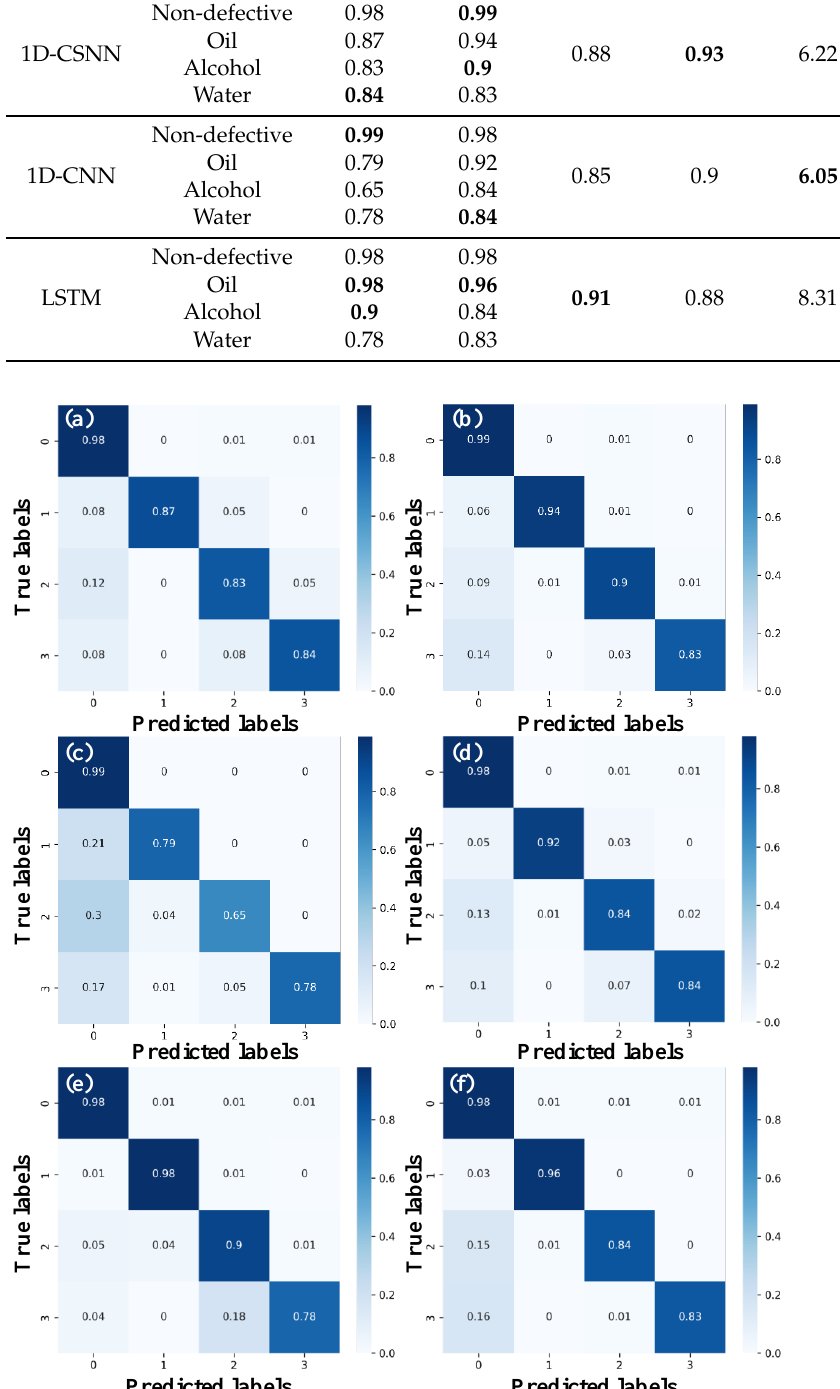
Figure 10. The confusion matrices of three one-dimensional sequence models: ( a , b ) 1D-CSNN, ( c , d ) 1D-CNN, and ( e , f ) LSTM. ( a , c , e ) are obtained based on time-domain signals, and ( b , d , f ) are based on frequency-domain